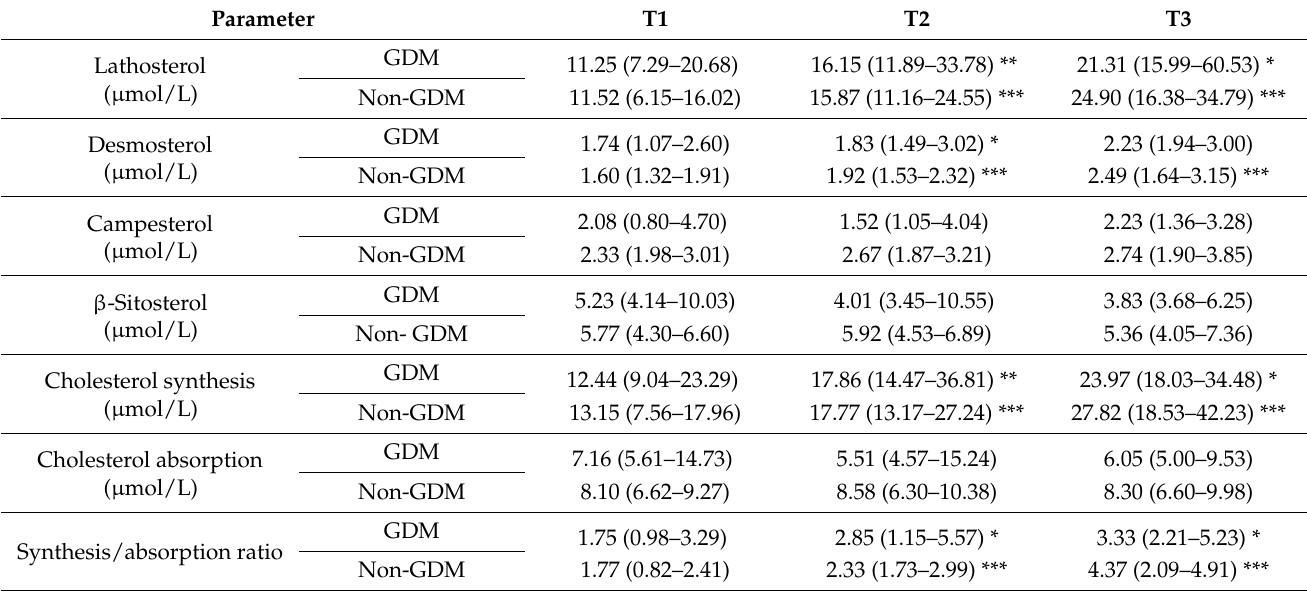
Table 4. Pattern of changes in cholesterol synthesis and absorption across trimesters in pregnant women with and without